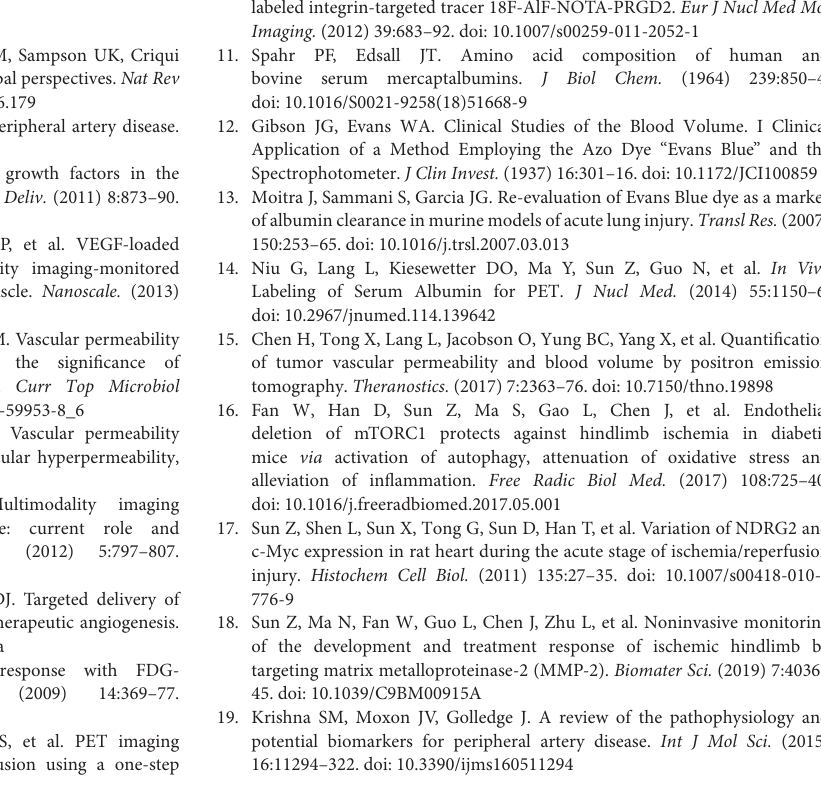
Supplementary Figure S1 | PET imaging was performed 15min post injection of 18 F-NEB. Supplementary Figure S2 | Representative photograph of CD31 immunohistochemical staining before surgery. Supplementary Figure S3 | H & E stained images of major organs (heart, lung, liver and kidney), harvested from mice 24h after injection with/without 18 F-NEB. Supplementary Video S1 | PET images were reconstructed by a three-dimensional ordered subsets expectation maximization (3D-OSEM)